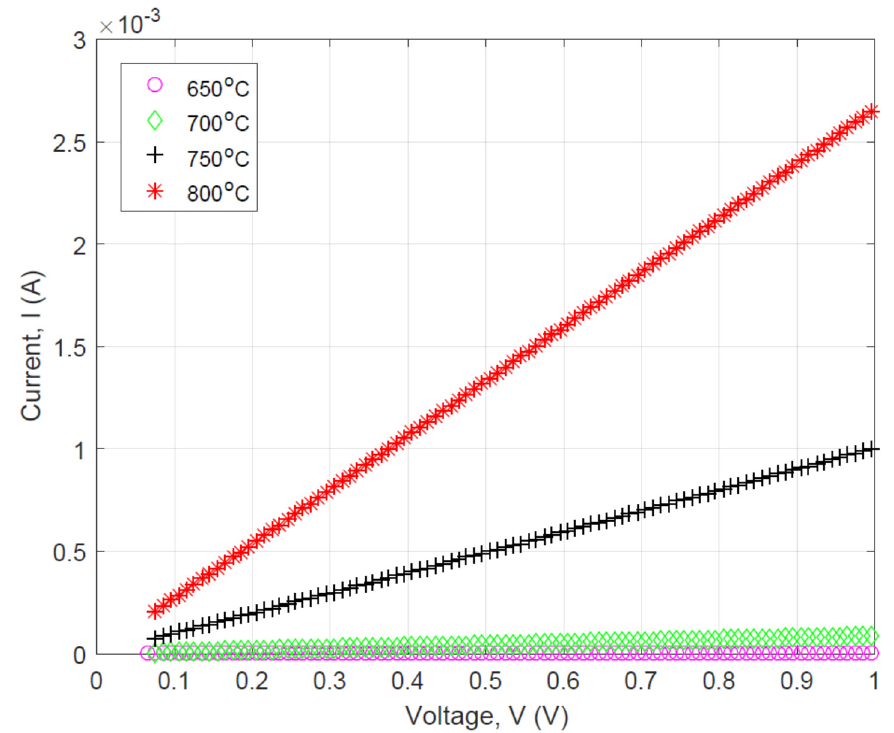
Figure 5. Electrical conductive measurement results of the carbon fiber heat treated at 650 °C, 700 °C, 750 °C, and 800 °C showing the transition of the fiber from semiconductor to a conductor.